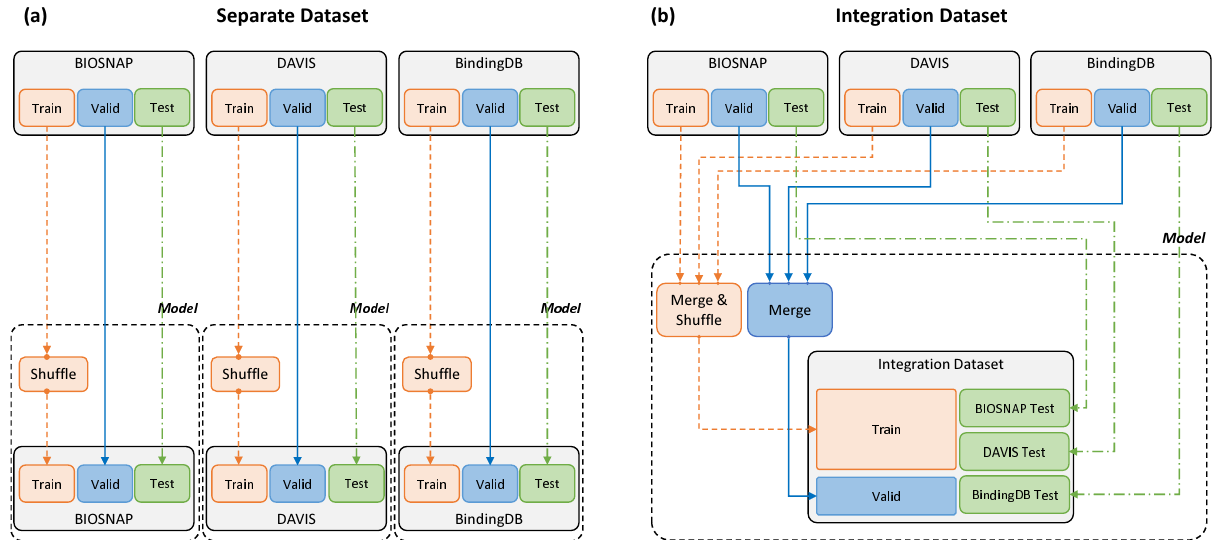
Figure 2. Separate and integration datasets. ( a ) A separate dataset was input by dividing the three datasets into training and validation test data for each model. ( b ) The integration dataset was used